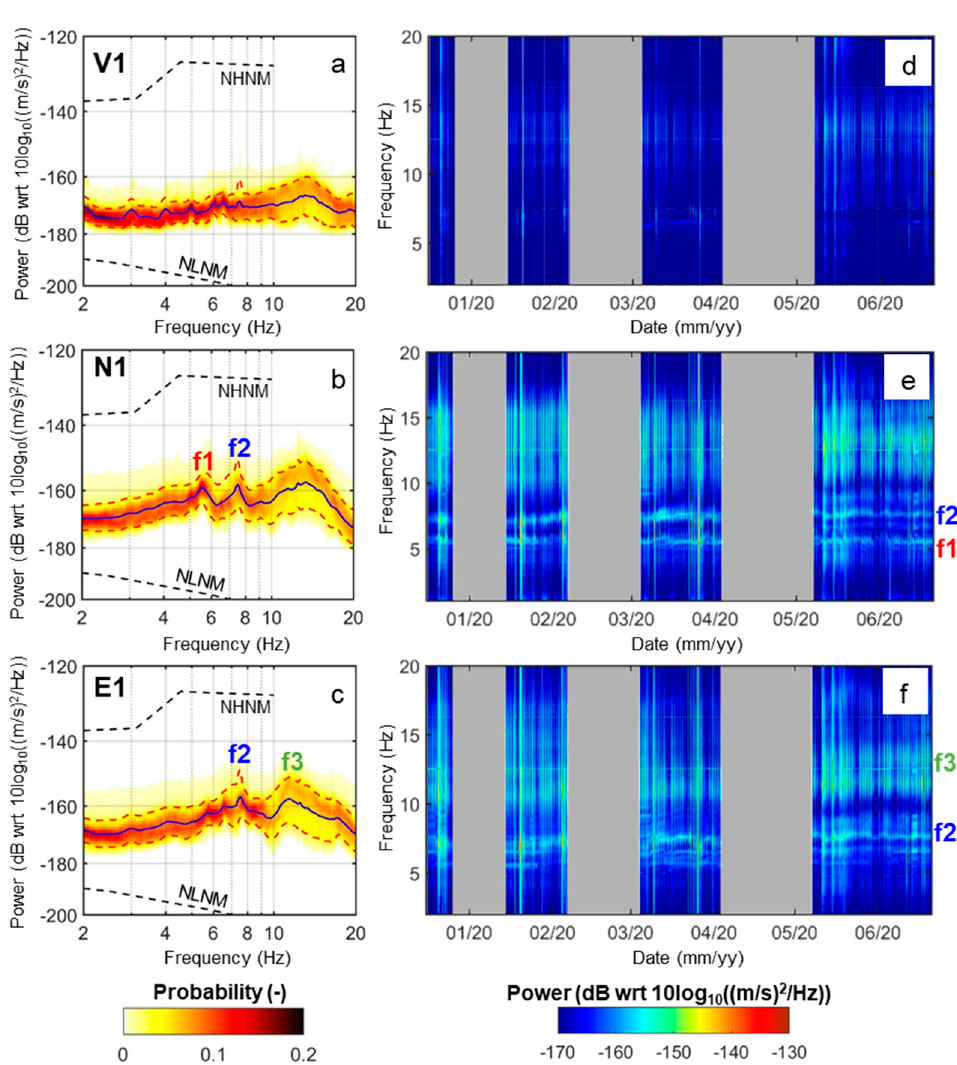
Figure 3. Spectral analysis of ambient seismic noise recorded at S1 (reference station). ( a – c ) PDFs of the hourly PSDs, with average (blue line) and 10th–90th percentiles (red dashed lines): ( a ) Vertical, ( b ) North and ( c ) East component. Black dashed lines: NHNM and NLNM boundaries [20]. ( d – f ) Hourly PSDs over the monitored period: ( d ) Vertical, ( e ) North and ( f ) East component. The main spectral peaks are highlighted with f1 to f3. No data periods are shaded in gray.